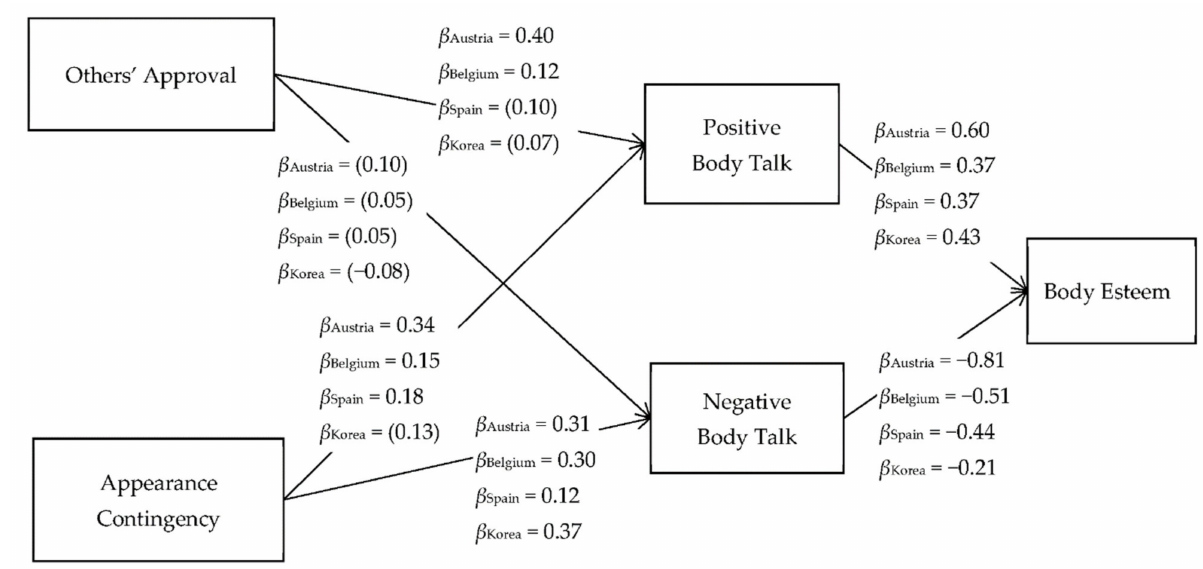
Figure 2. The final model of the relationships between others’ approval, appearance contingency, positive and negative body talk, and body esteem among girls. Note that the values are the observed standardized path coefficients. The path coefficients without parentheses are significant at p <